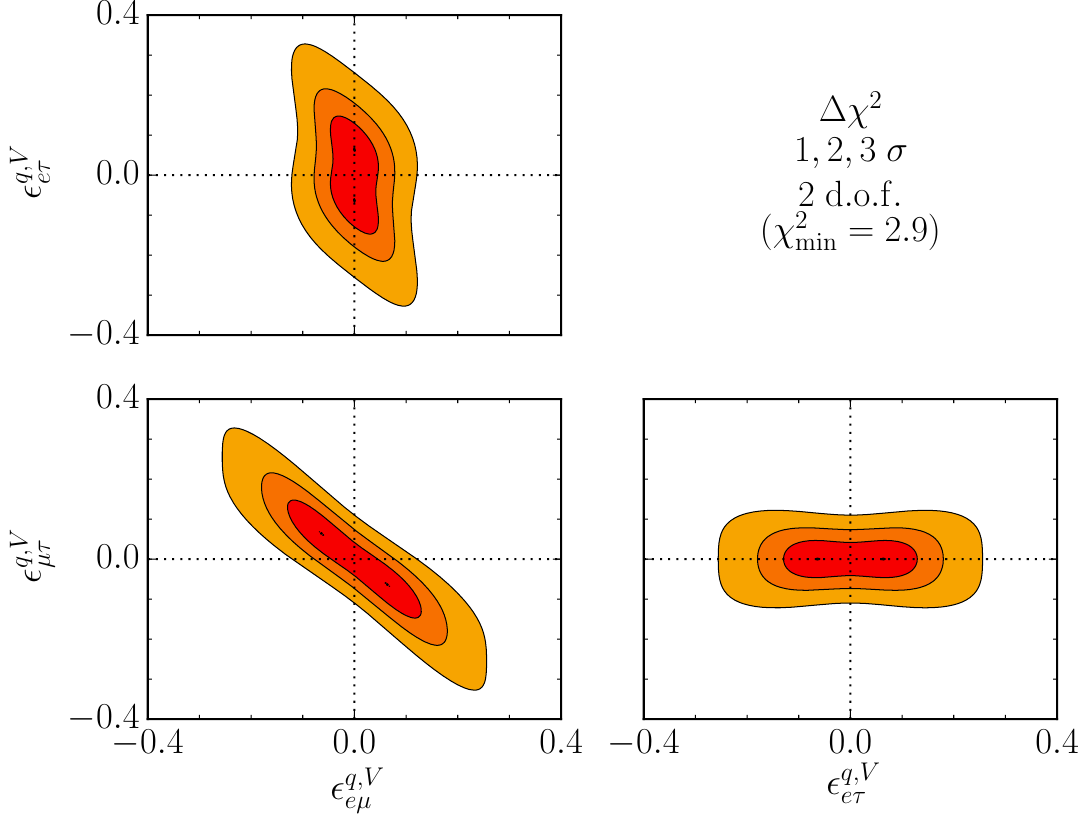
Figure 4 . The 1, 2, and 3 (cid:27) (cid:1) (cid:31) 2 constraints (2 d.o.f.) for o(cid:11)-diagonal NSI from COHERENT’s measurement using timing information where all other NSI terms are set to zero. We have assumed that (cid:15) u = (cid:15) d as required by underlying models for NSI and have taken the mediator to be heavy. The minimum (cid:31) 2 is 2 :